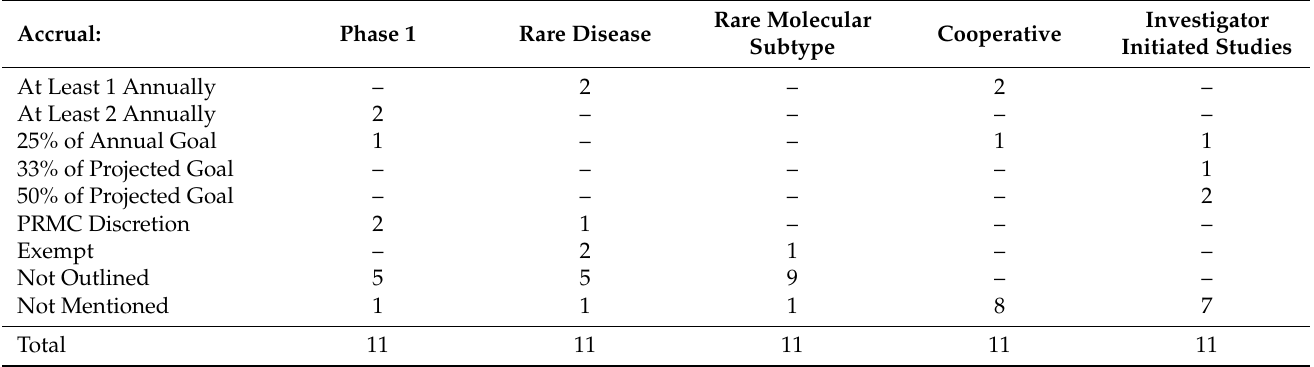
Table 6. Minimum accrual expectations detailed in PRMC charters and policies found via web query of PRMC charters available online. A total of 11 online charters were